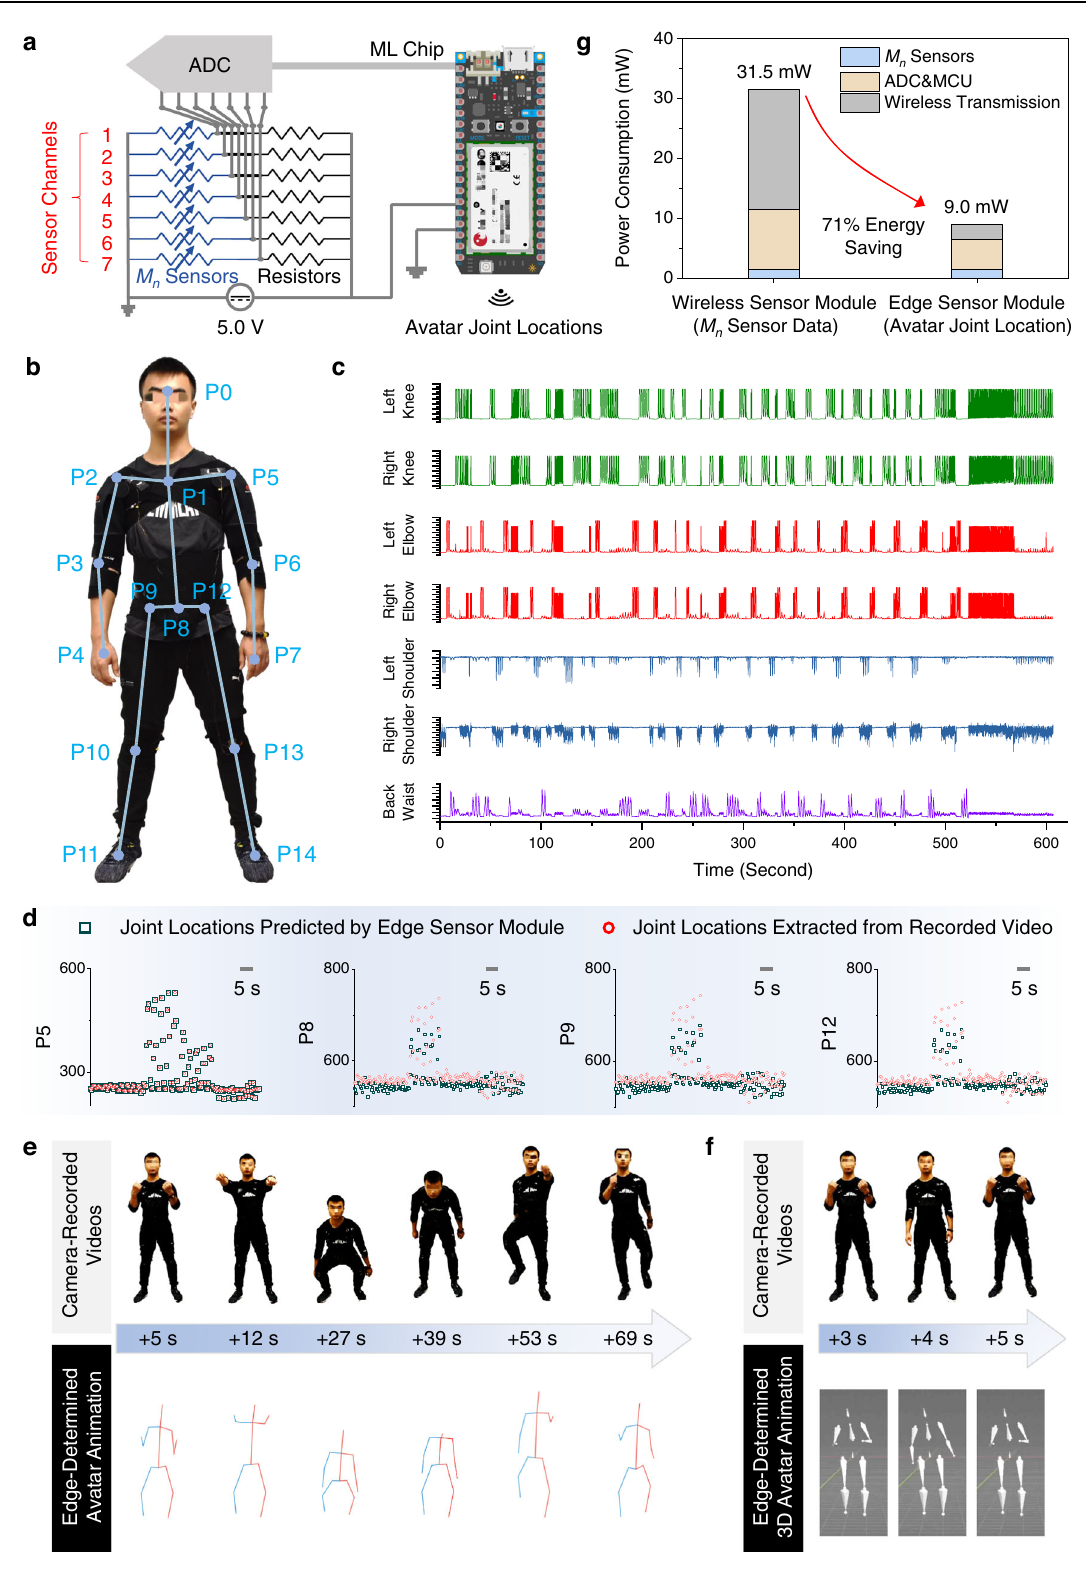
Fig. 5 | Edge sensor module for in-sensor avatar reconstruction. a Equivalent circuit of an edge sensor module. b Stickman avatar with 15 joints was customized based on a camera-recorded video. c Time-dependent M n sensor data in response to various full-body motions of a volunteer. d Joint location comparison between the determination results from an edge sensor module and the extracted